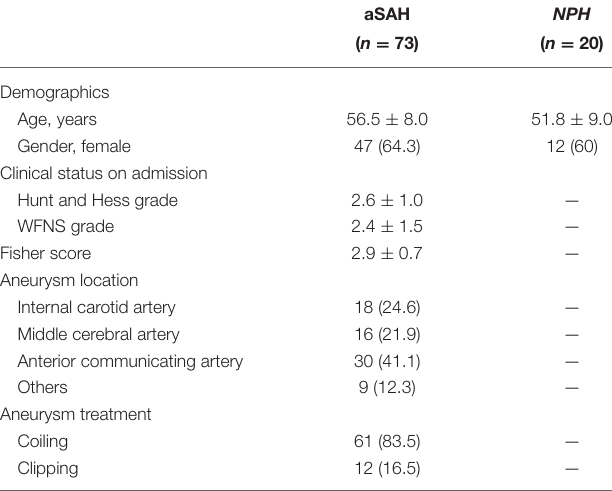
TABLE 4 | Characteristics for patients.